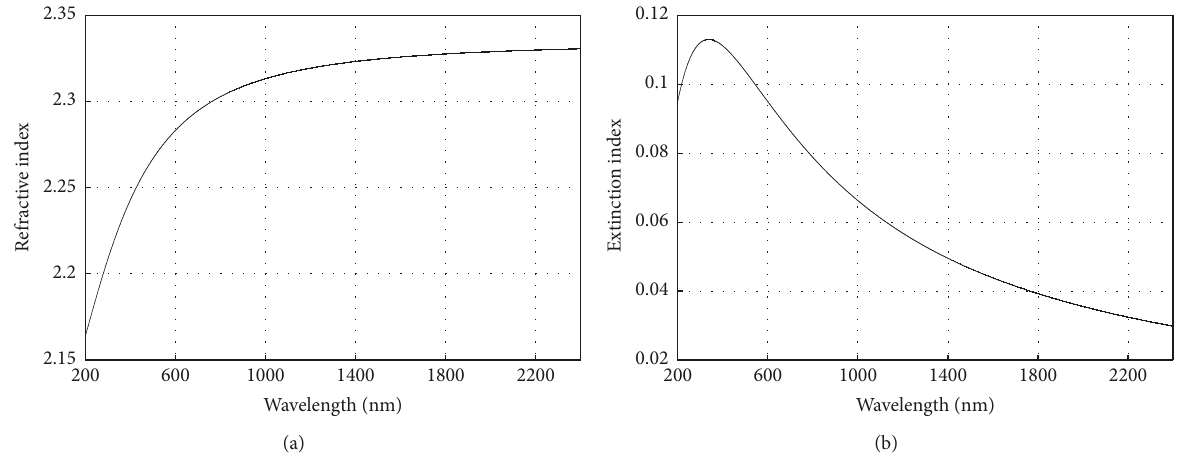
Figure 7: Comparison of the real (a) and imaginary (b) parts of the complex refractive index for the as-deposited thin film (see Figure